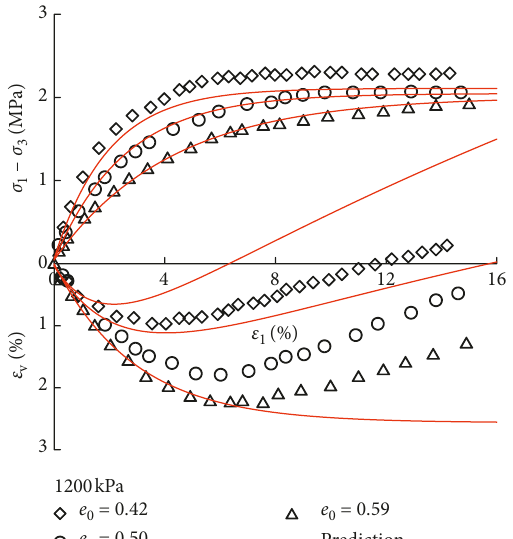
Figure 15: Experiment result and prediction of rockfill materials under 500 kPa confining pressure with different void